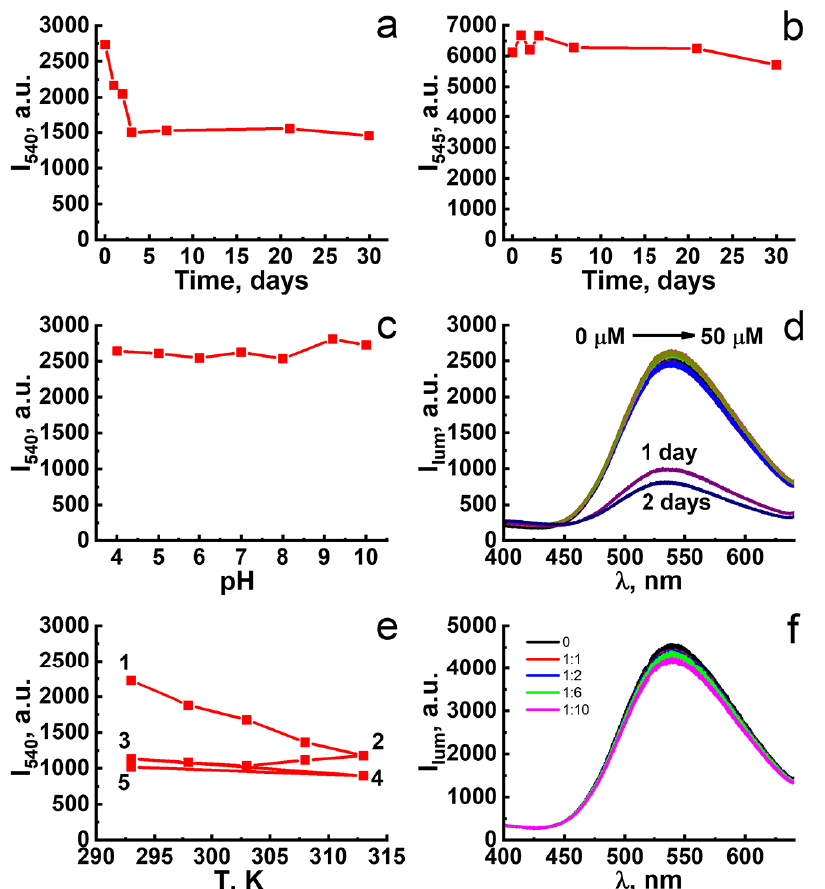
Figure 6. Emission intensities of diluted ( a , C = 20 µ M) and concentrated ( b , C = 200 µ M) F-127- Cu 2 I 2 L 3 colloids versus storage time. ( c ) Emission intensities of F-127-Cu 2 I 2 L 3 colloids (C = 20 µ M) in solutions at different pH values. ( d ) Luminescence spectra of F-127-Cu 2 I 2 L 3 colloids (C = 20 µ M) in the presence of H 2 O 2 . ( e ) Emission intensities of F-127-Cu 2 I 2 L 3 colloids (C = 20 µ M) at different temperatures: 1-2-3—first heating–cooling cycle, 3-4-5—second heating–cooling cycle. ( f ) Luminescence spectra of F-127-Cu 2 I 2 L 3 colloids (C = 40 µ M, pH = 7.0) at different concentrations of GSH designated as molar ratios Cu:GSH in Figure legend. λ ex are 330 nm and 365 nm for diluted and concentrated solutions,